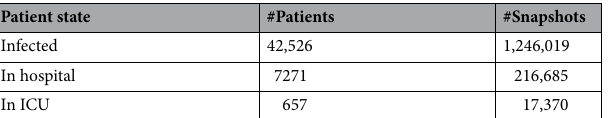
Table 1. An overview of the data sets and the number of patients in different states: patients tested positive with SARS-CoV-2, patients admitted to hospital, and patients admitted to ICU.